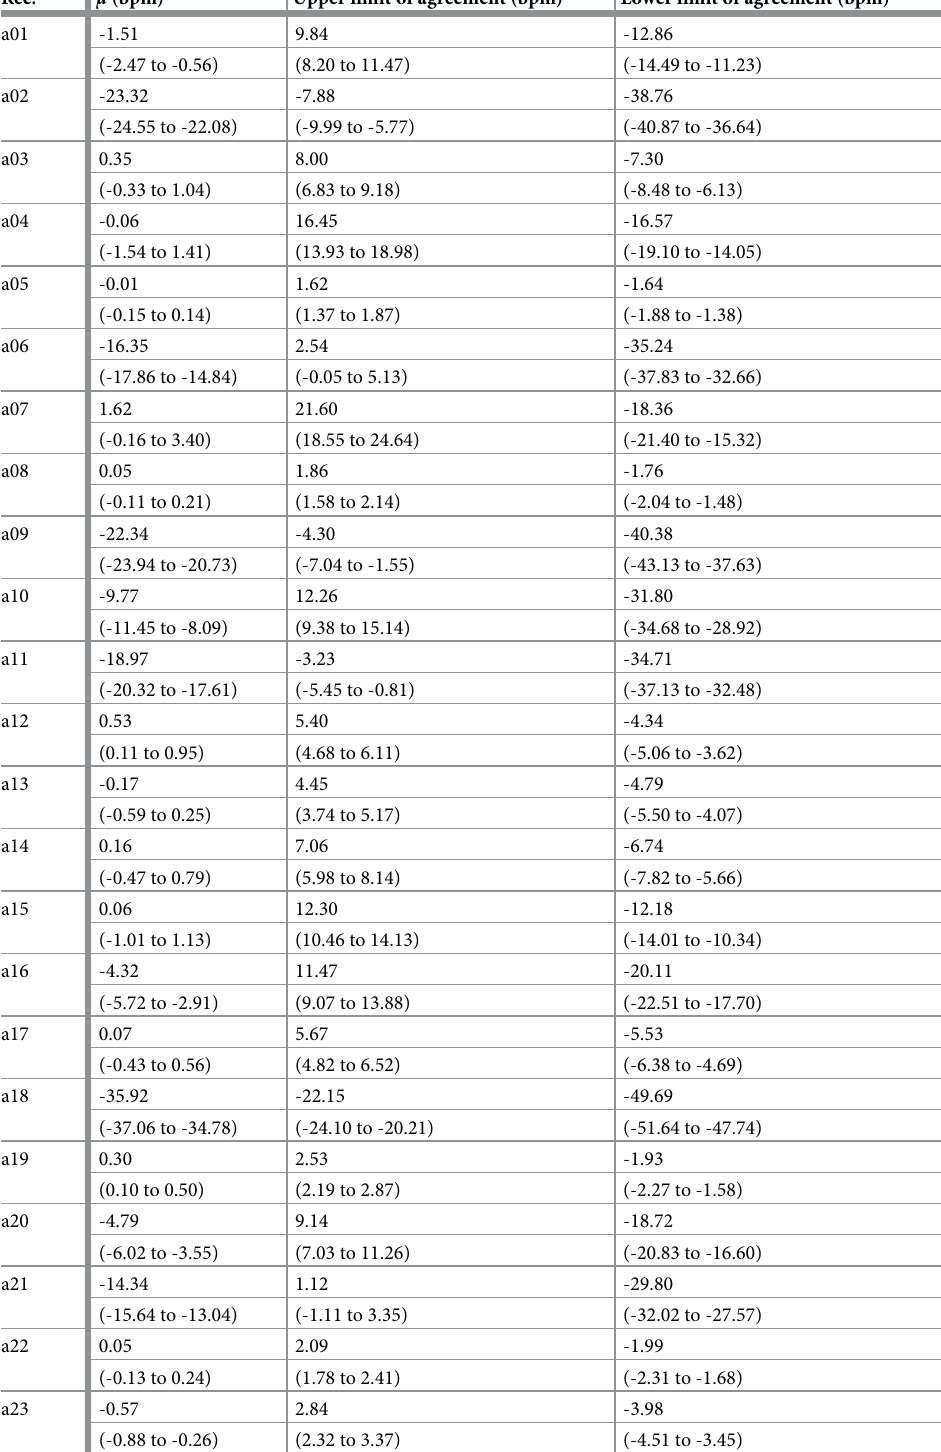
Table 5. Mean values μ and values of limits of agreement determined by the ICA-RLS-EEMD method for record- ings from the Challenge database (the 95% confidence interval is reported in parenthesis).